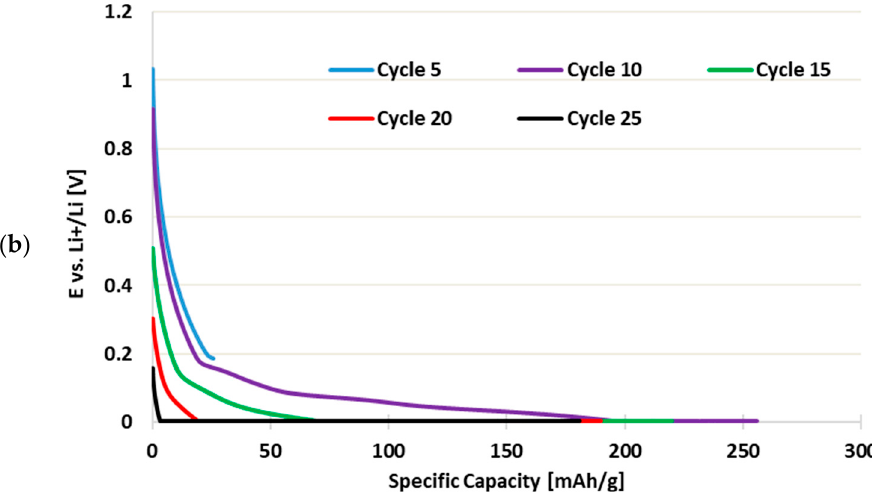
Figure 11. Discharge of anode half-cells with C-rates of ( a ) C/5, and ( b ) C/10. Results for discharging cathode half-cells at C/5 C-rate are shown in Figure 12a. After 21 cycles, the capacity is 138 mAh/g. Capacity drops to 85 mAh/g after 52 cycles and finally reaches 39 mAh/g after 71 cycles. Moreover, Figure 12b includes results for discharging half-cell cathodes at C/10 C-rate. This showed an initial capacity of 157 mAh/g which consistently drops every 25 cycles until reaching a capacity of 130 mAh/g after 50 cycles. After 70 cycles, the capacity is 90 mAh/g which is 57% of the initial capacity. For all tests, specific capacity was normalized by the mass of electrode active material. The capacity retention of the cathode half-cell tested at both C-rates is shown in Figure 13a along with a comparison to cathodes using fresh Al CC. For C/5, the capacity retention after 50 cycles is 84% while it is 83% for C/10. In contrast, the fresh CC cathode shows a capacity retention of 96%. When compared to the fresh CC cathode, capacity is lower; however, the cathode half-cells still retain more than 80% of the initial capacity. Capacity retention results for anode half-cells are shown in Figure 13b. The two test conditions of C/5 and C/10 do not show any significant difference in capacity retention.